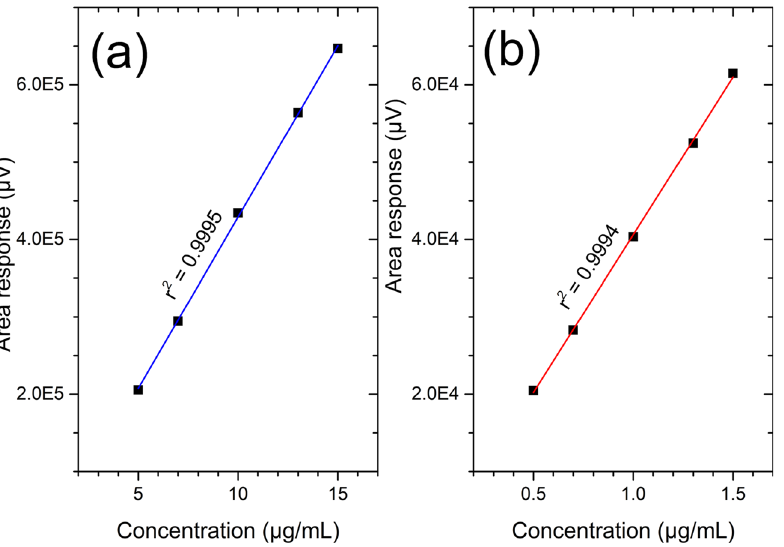
Figure 5. Concentration vs. area response graph of ( a ) CBD and ( b ) THC for accuracy and range testing for assay.